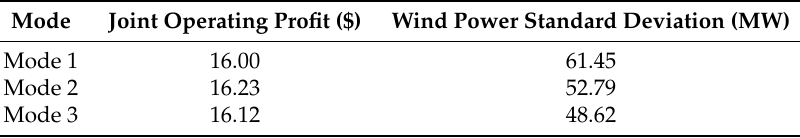
Table 2. Comparison of optimization effects in three